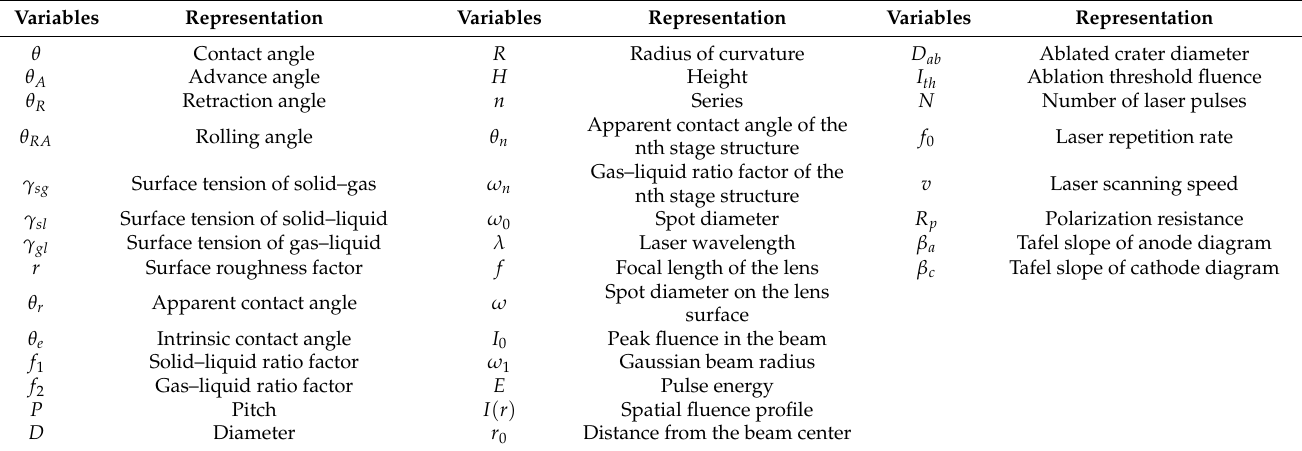
Table 2. Summary of variables’ representation.